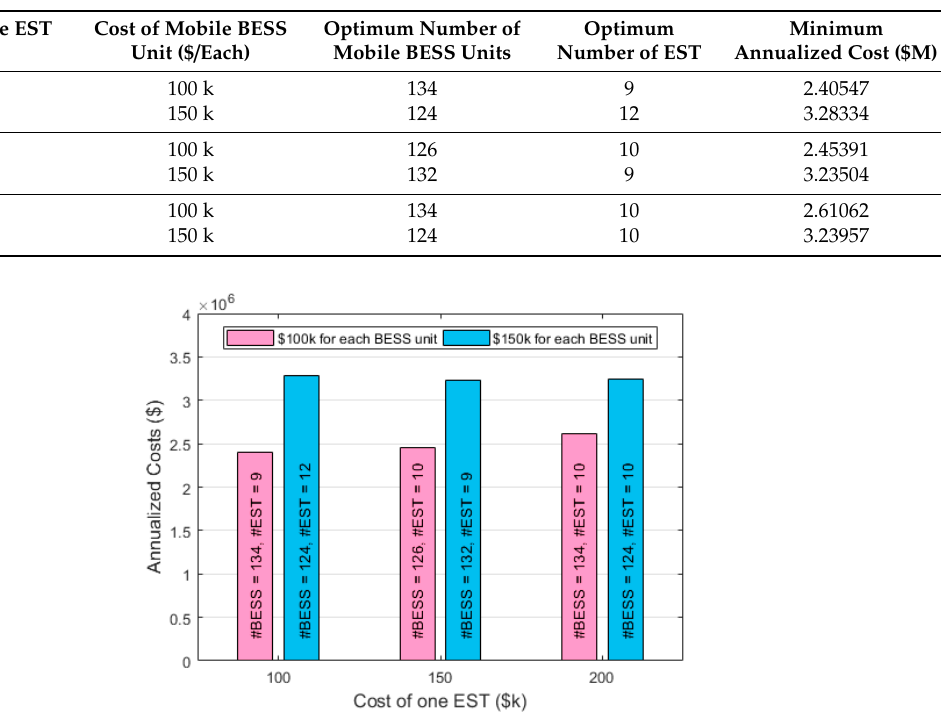
Table 2. Summary table of the optimization results under varying costs of EST and mobile BESS unit.